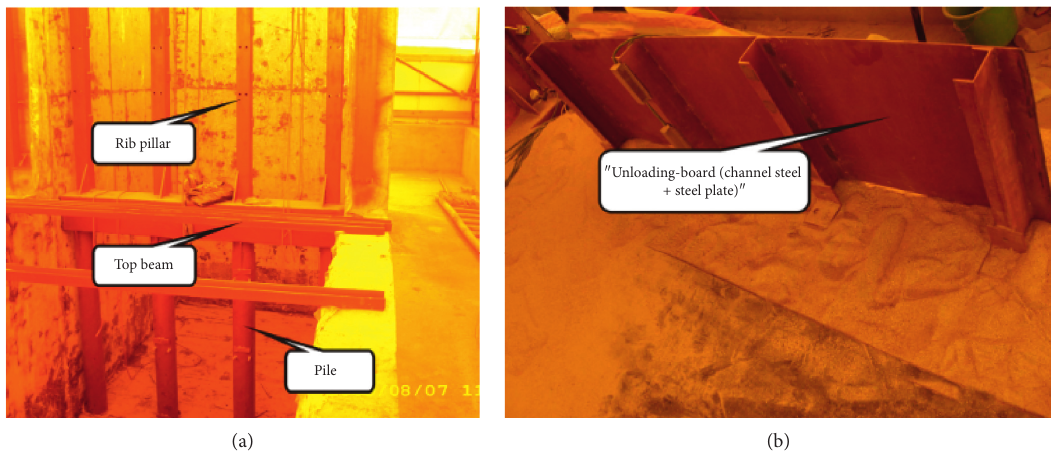
Figure 3: Real figure of the model structure. (a) Real figure 1. (b) Real figure 2.